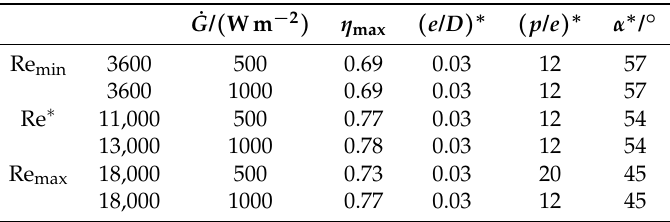
Table 11. Maximum efficiency and optimum roughness parameters according to the model developed by Yadav et al.